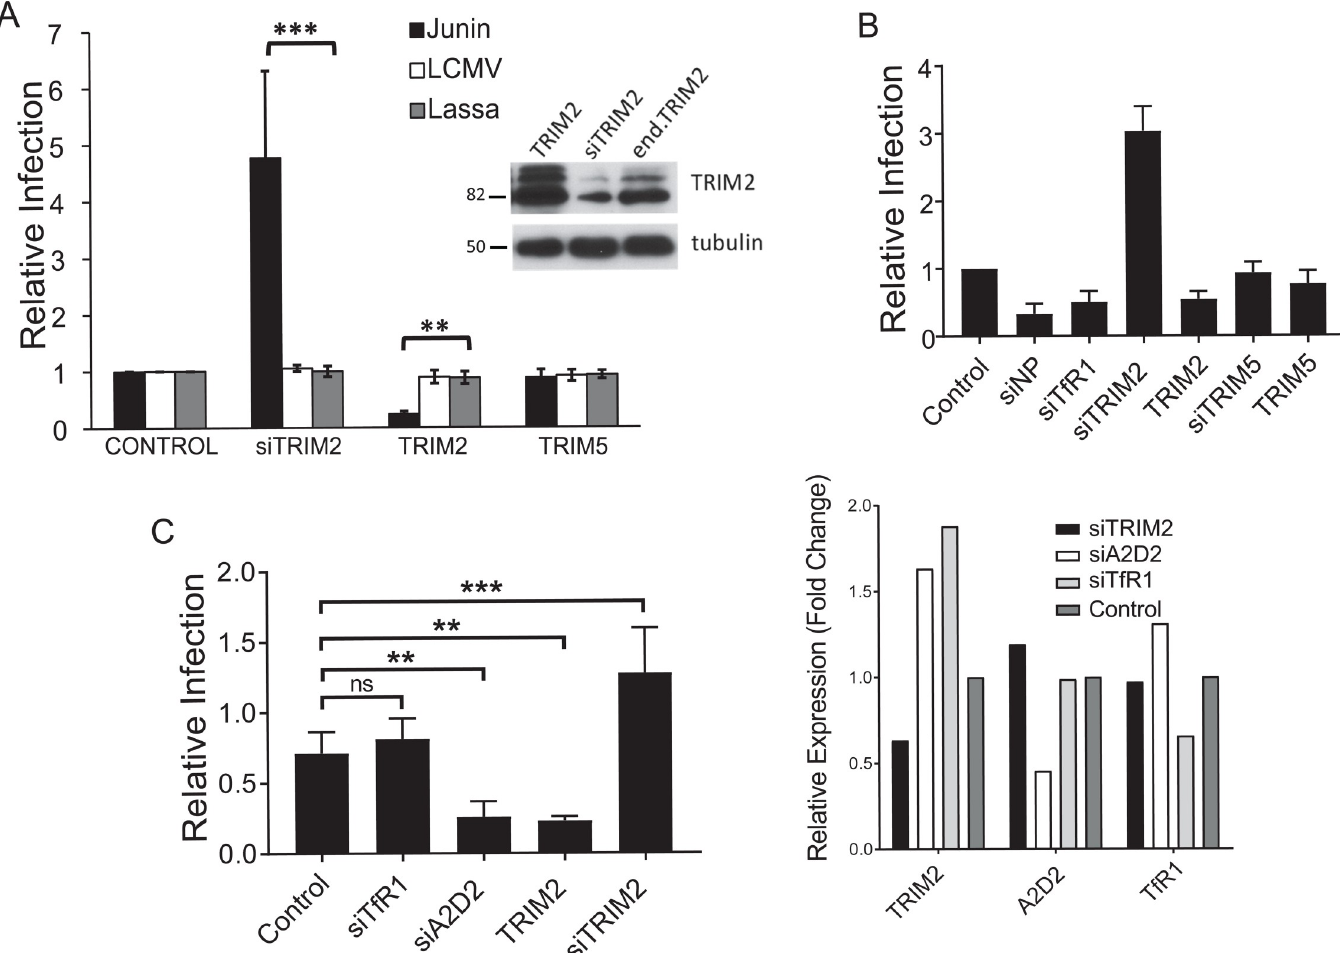
Fig 1. Overexpression of TRIM2 decreases Junı´n virus but not OWA infection. (A) U2OS cells were transfected with TRIM2 or TRIM5 α expression vectors and 24 hr later were infected with Junı´n virus, Lassa virus, or LCMV GP-pseudoviruses containing the luciferase gene. The data shown are the average and SD of 3 independent experiments. Western blot is from U2OS cells and those transfected with the TRIM2 expression vector or siRNA. Blots were probed with anti-TRIM2 and anti- β -tubulin antisera. (B) U2OS cells were transfected with the indicated siRNAs or TRIM expression vectors and 24 hr later were infected with Candid 1 (MOI 0.1). Reverse- transcribed RT-qPCR for the nucleoprotein RNA was analyzed. Values represent the mean ± SD in 2 independent experiments with triplicate experimental replicates. Control refers to cells treated with a control siRNA. (C) U2OS cells were transfected with the indicated siRNAs and expression vectors and infected with Tacaribe virus; the panel on the right shows the knockdown of each gene. The data shown represent the average and SD of 3 independent experiments. One-way ANOVA was used to determine significance. �� P � 0.005; ��� P � 0.0005. A2D2, calcium channel subunit α 2 δ 2; LCMV, lymphocytic choriomeningitis virus; MOI, multiplicity of infection; OWA, Old World arenavirus; RT-qPCR, real-time quantitative PCR; siRNA, short interfering RNA; TfR1, transferrin receptor 1.